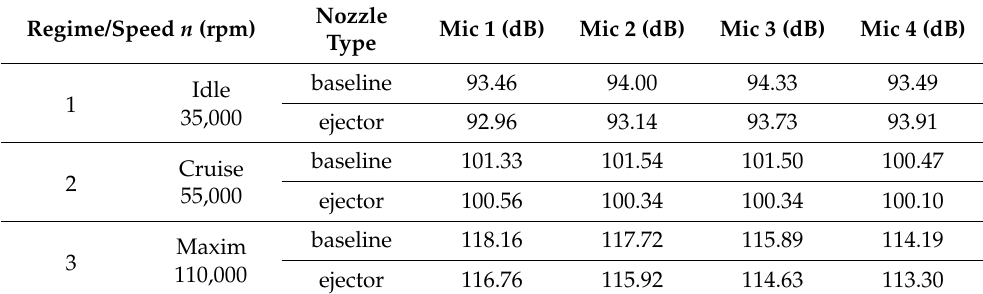
Figure 24. Averaged OASPL variation depending on the tested regime and nozzle configuration.